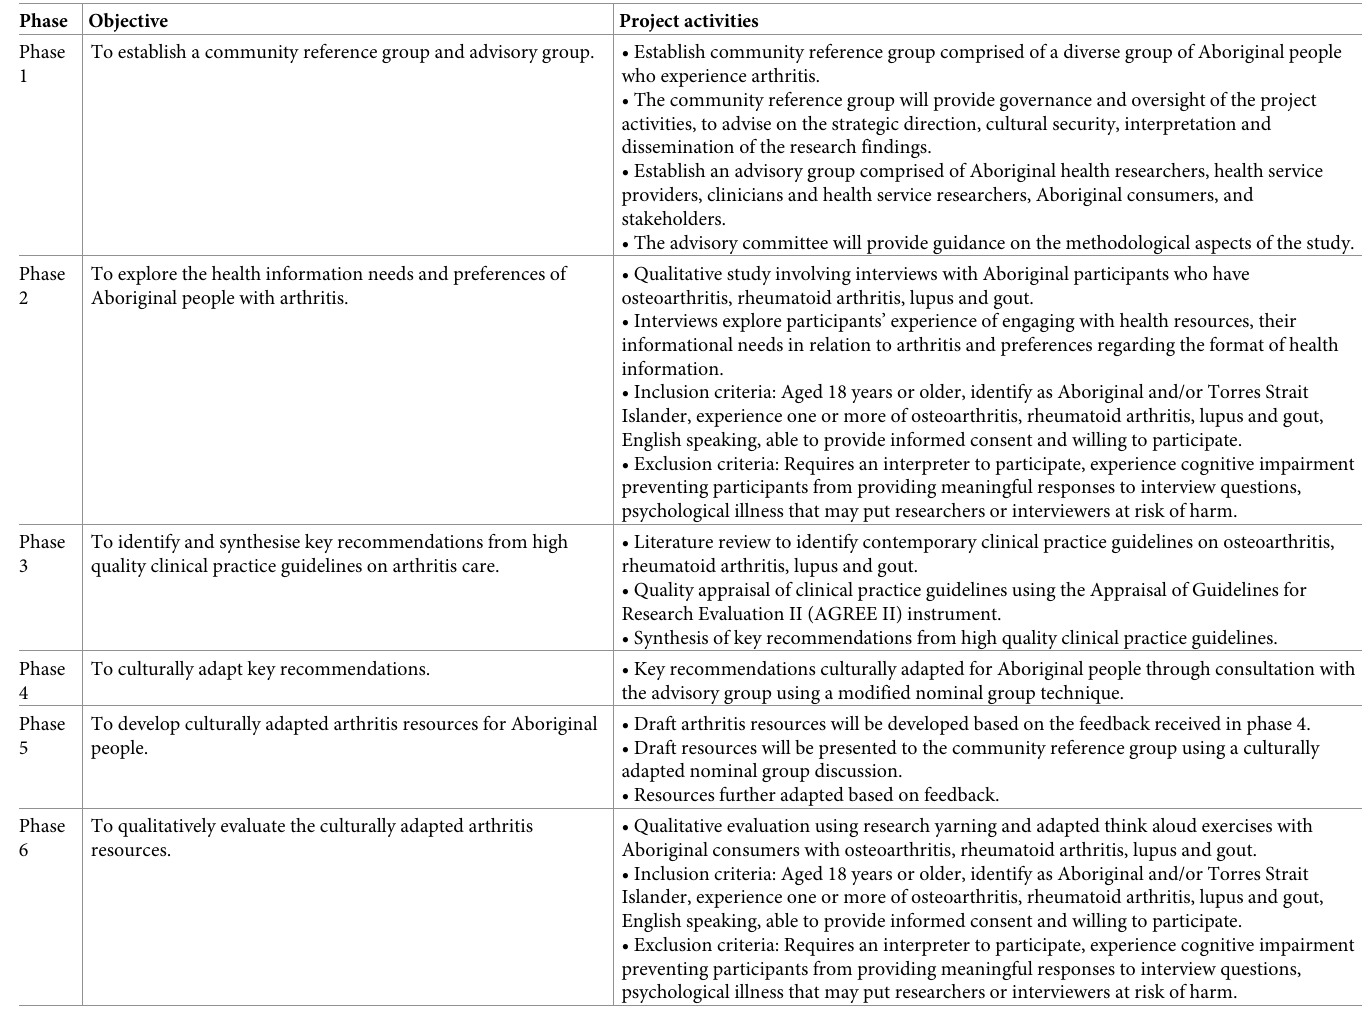
Table 1. Overview of project